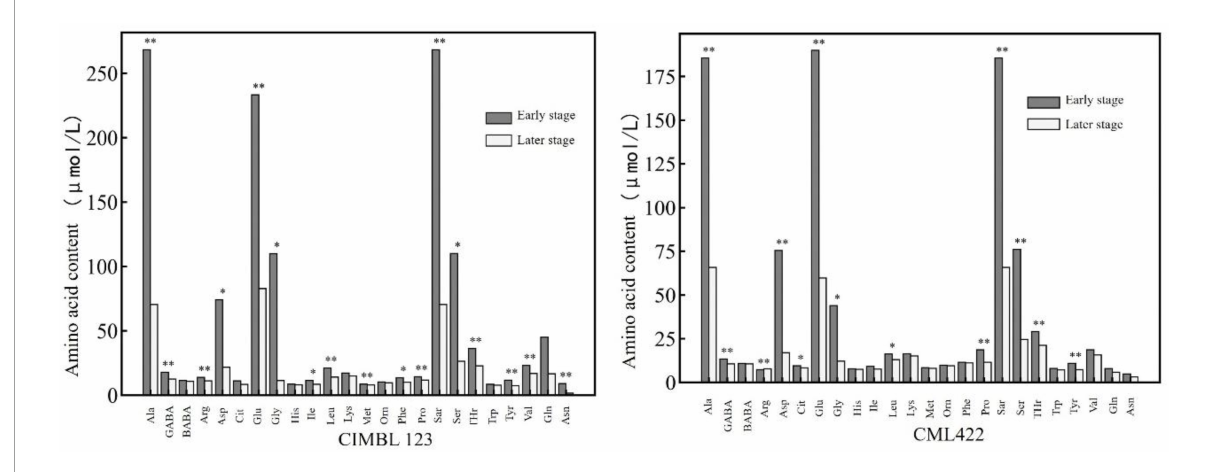
FIGURE2 The contents of various amino acids in the leaves of two inbred lines at the early and later stages of nitrogen starvation treatment. ∗ and ∗∗ represent significance at the 0.05 and 0.01 probability level ( p < 0.05 and P < 0.01).